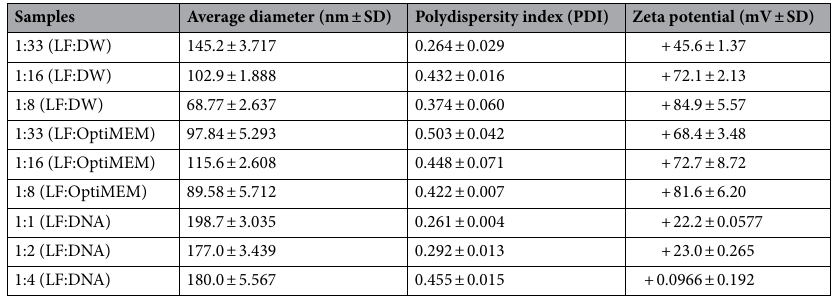
1:2 liposomes to nucleic acid were best for formation of nanomeric complexes (Supplementary Fig. S1e,f online). Based on surface charge, 1:1 and 1:2 liposomes to nucleic acid ratios showed high positive zeta potential values (Table 1), whereas 1:4 ratio exhibited an almost neutral surface charge (Table 1). This may be explained by the change in zeta potential values where the ratio (LF:DNA) was 1:1 and 1:2 the complex (lipoplex) between cati- onic lipidic-molecule (LF) and DNA due to electrostatic interaction between the amine functional group of LF molecule and anionic phospholipid group of DNA. When the DNA was condensed the zeta potential exhibited a positive surface charge density (+ 22 (1:1 ratio) and + 23 (1:2 ratio) mV) as seen in Table 1. The increase in amount of DNA beyond 1:2 ratio would need more LF to interact and condense DNA as the zeta potential was reduced at 1.4 ratio, thus 1:2 was deemed the best liposome to nucleic acid ratio for transfections. Based on the TEM analysis, LF particles exhibited an irregular shape of less than 50 nm (35.01 ± 9.77) (Fig. 1a,b). Once mixed with DNA, nanomeric complexes appeared as rounded particles, up to 100 nm in size, showing electron-lucid core DNA, wrapped in electron-dense lipid (Fig. 1c,d). Non‑viral transfections and characterisation of ICs.